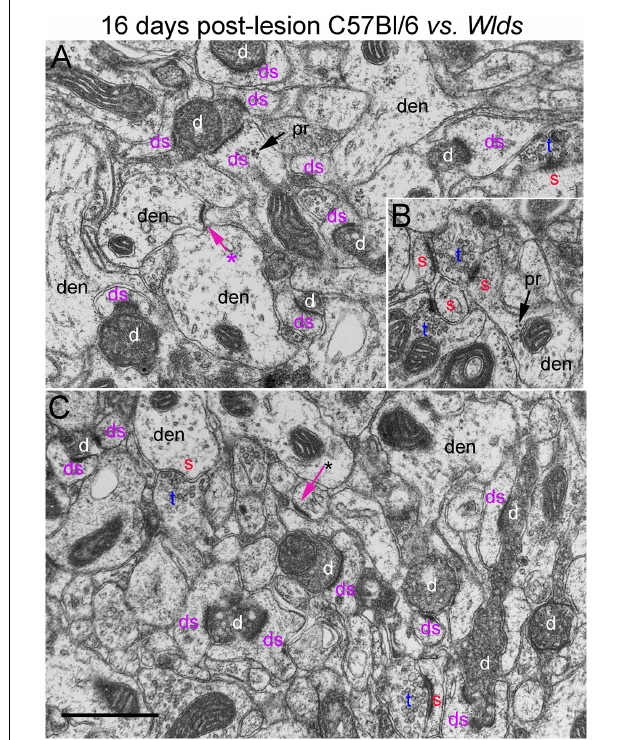
FIGURE 9 | Ultrastructure of synapses at 16 days post-lesion in C57Bl/6 and Wld s mice. (A) Dark-dense terminal contacting multiple spine heads in C57Bl/6 mice. Arrows indicate empty PSDs (not contacted by either an intact or degenerating presynaptic terminal). Upper arrow indicates empty PSD apposed by astrocyte process. (B) Non-degenerating presynaptic terminal contacted multiple PSDs. (C) Terminals exhibiting dark-dense degeneration at 16 days post-lesion in Wld s mice. Red s (red), spine head; t (blue), non-degenerating synaptic terminal; d (white) degenerating synaptic terminal; ds (purple) spine contacted by degenerating presynaptic terminal; den, dendrite; pr, polyribosomes. Calibration bar in (C) = 0.25 µ m and applies to (A–C) . *empty